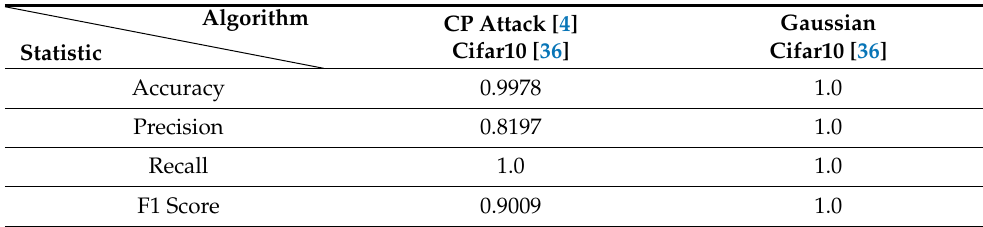
Table 10. Detection performance of IDA algorithm for “other attacks”. (Note that reconstruction error threshold is